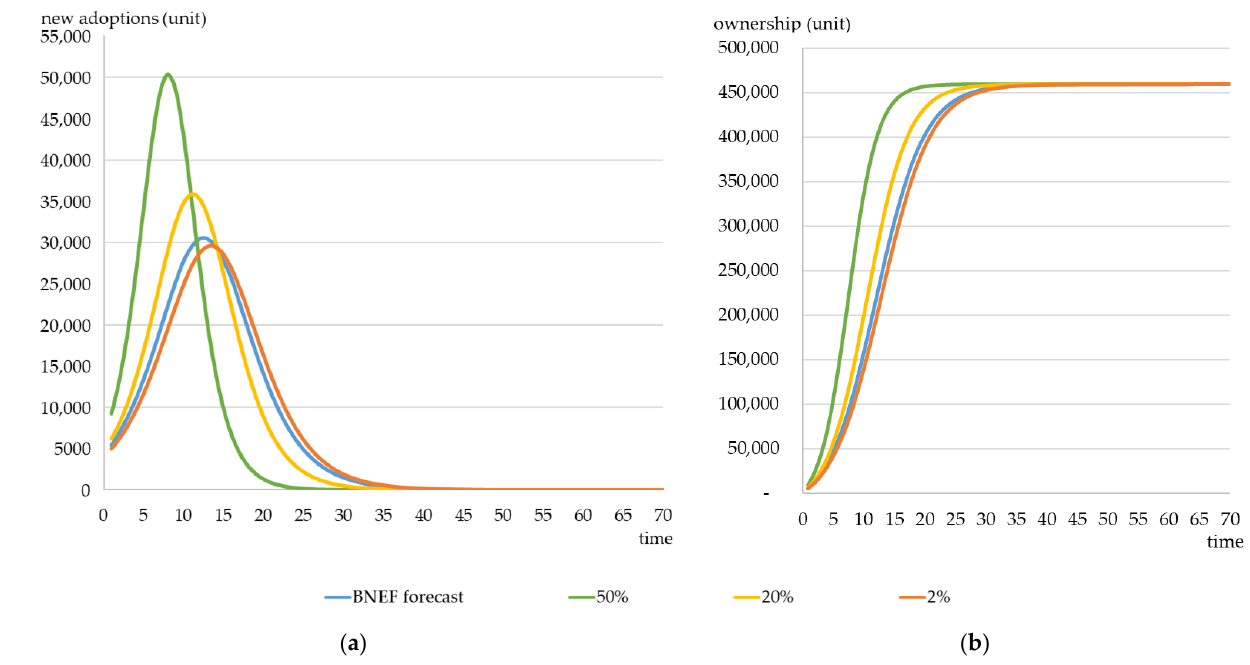
Figure 4. ( a ) In the scenario with a 100% replacement rate, the numbers of new adoptions, which are simulated in accordance with the BNEF estimation, involve annual drops of 50%, 20% and 2%; ( b ) In the scenario with a 100% replacement rate, the numbers for ownership, which are simulated in accordance with the BNEF estimation, involve annual drops of 50%, 20% and 2%.